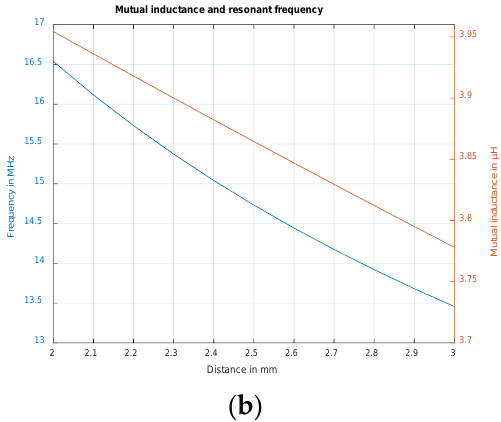
Inserting (6) into (7) and (7) into (8), we obtain the mutual inductance for each com- bination of turn and ring. The resulting total mutual inductance can be determined by adding the individual values.